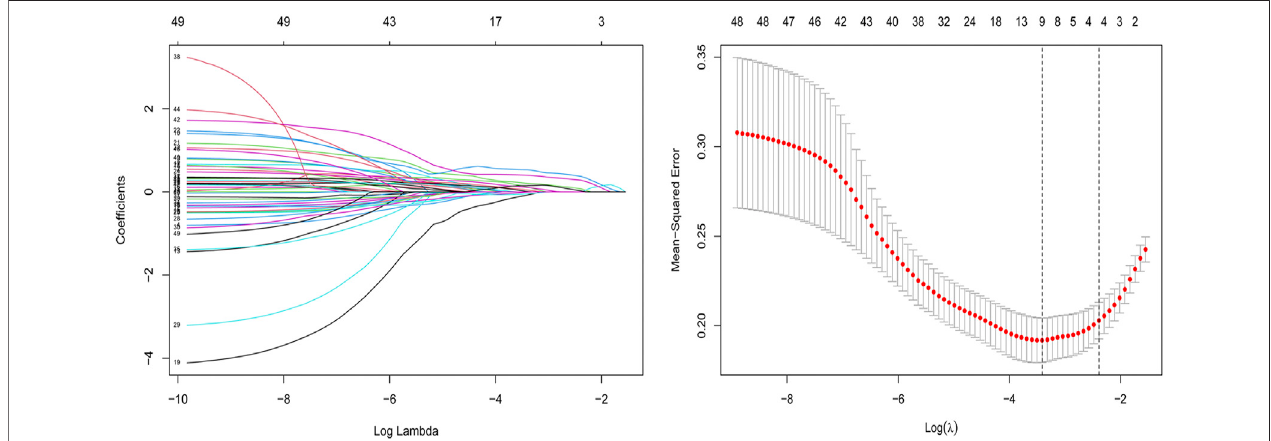
FIGURE 3 | Feature selection for the LASSO logistic regression. The selection of the tuning parameter ( λ ) using a 10-fold cross-validation. At minimal value of the mean square error of the classi fi cation, the dotted vertical line ( λ (cid:1) 0.033) was drawn, including 11 optimal features with nonzero coef fi cients. The histogram of 11 radiomics features was presented.